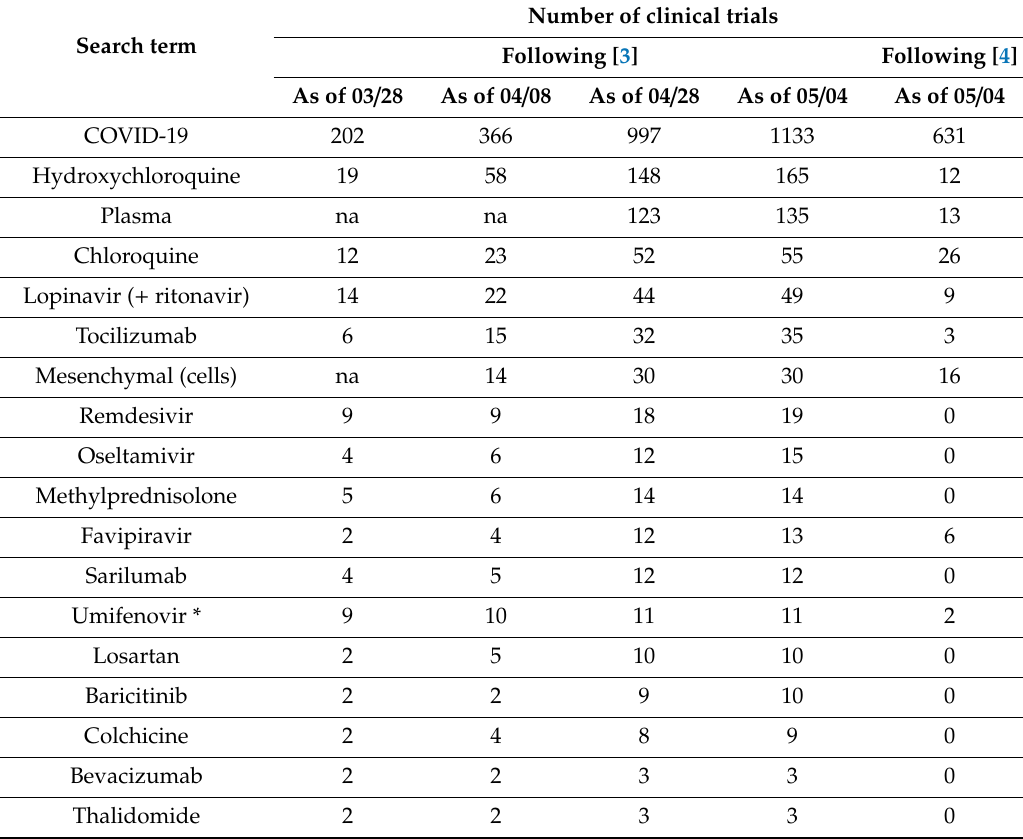
Table 1. Most cited potential treatments for COVID-19 following the U.S. National Library of Medicine [3] and the Chinese Clinical Trial Registry